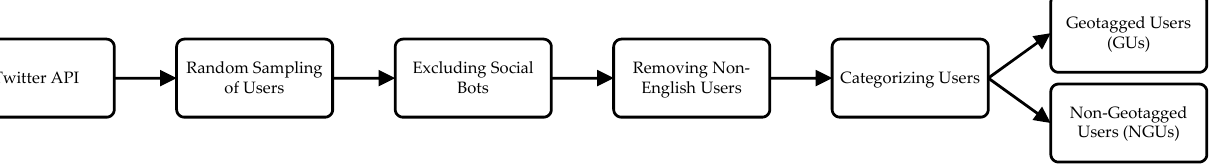
Figure 1. Data collection and preprocessing steps .